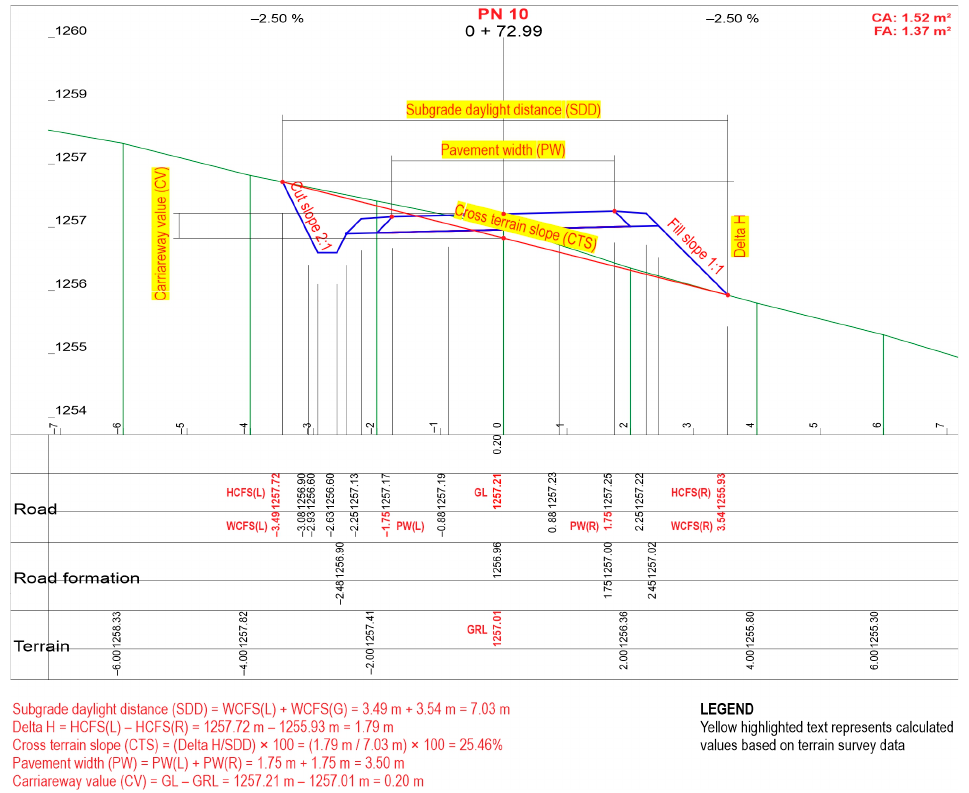
Figure 2. Example of cross section elements used in analysis of cross sectional profile 10, forest road “Mari č i ć a vrh”.